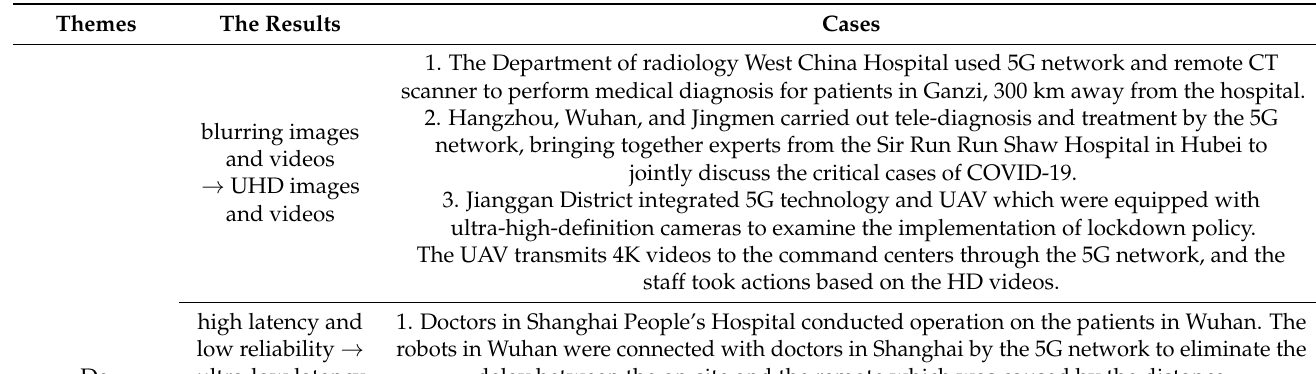
Table 6. The process of the coding of de-spatialization and